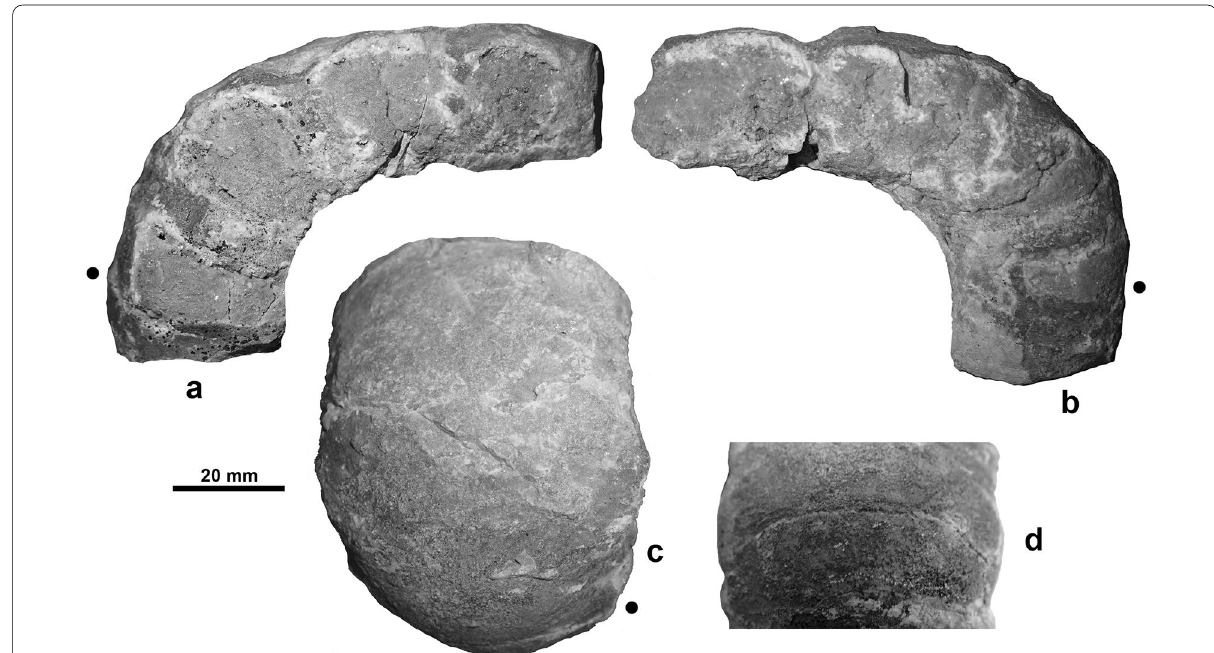
Fig. 6 Nautilida gen. et sp. indet., PIMUZ 38668, P. 902/ Mirigioli (Monte San Giorgio), Middle Besano Formation (bed 98), uppermost Anisian: a lateral view, left side, b lateral view, right side, c ventral view, d aboral portion of ventral view showing suture line (ventral saddle). In figs. a and b the umbilical wall is not visible because is embedded in the matrix (here not showed), so it is difficult to judge where exactly the dorsum ends. The black point beside a , b , c , marks where was observed the suture line showed in